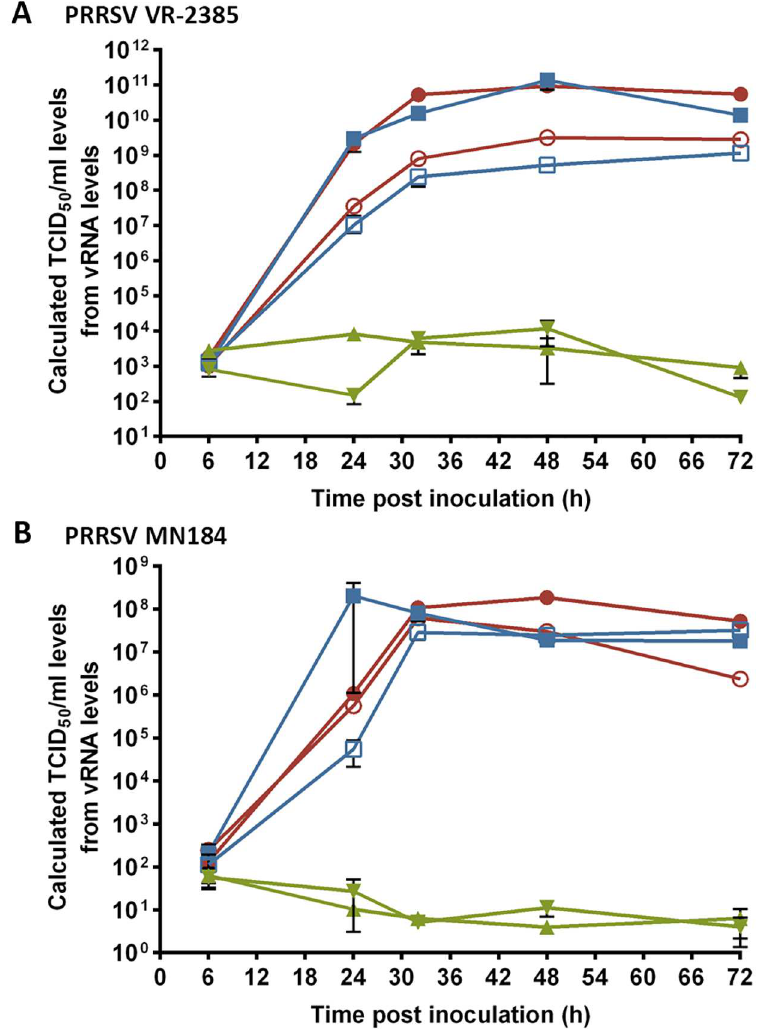
Fig 6. Δ SRCR5peripheral blood monocyte-derived macrophages (PMMs) are not susceptible to infection with PRRSV genotype 2. Replicationof PRRSV on PMMs in long-terminfectionswith genotype2, A) highly virulent strain VR-2385, and B ) highly pathogenicstrain MN-184. PMMs from wild type (red, 628 filled circle, 633 open circle), heterozygous (blue, 627 filled square, 633 opensquare), and Δ SRCR5(green, 629 trianglepointingdown, 630 trianglepointing up) animalswere inoculatedat MOI = 0.1 of the respective strain. Cell supernatant was collectedat indicatedtime points to measurethe releasedviral RNA by RT- qPCR. Error bars represent SEM, n = 3 *